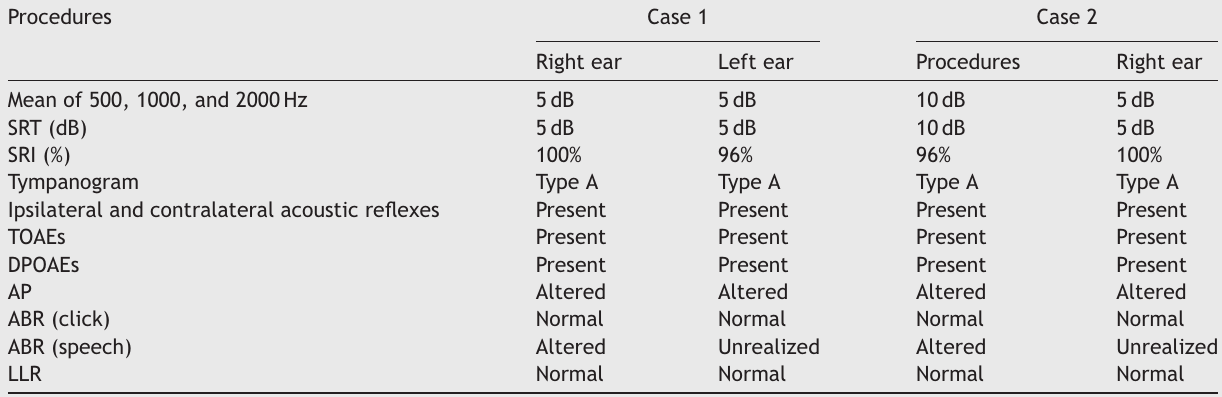
Values of the performed hearing